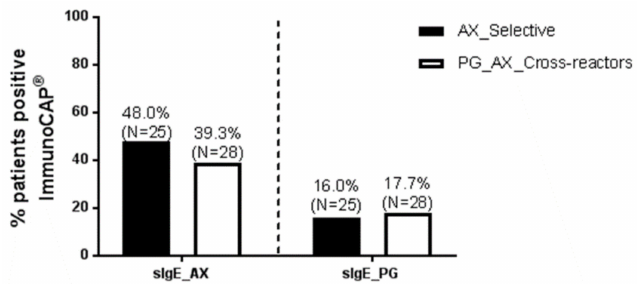
Figure 4. Percentage of positive sIgE to PG or to AX in a subgroup of Spanish patients confirmed as AX selective or PG_AX cross-reactors by drug provocation